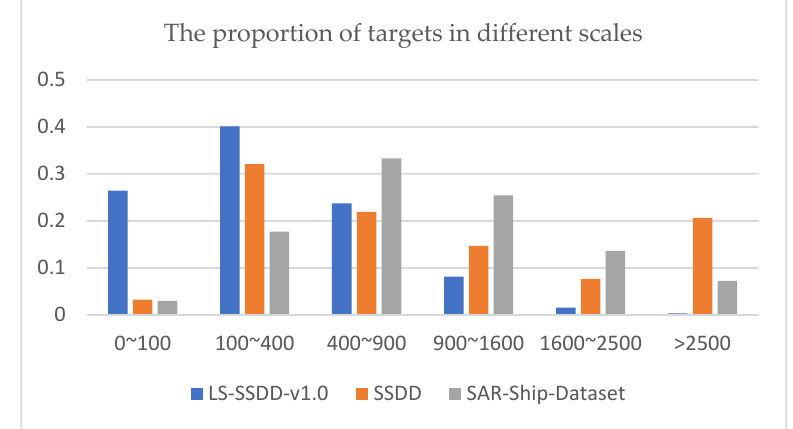
Figure 6. Comparison of thermal diagrams before and after refinement.